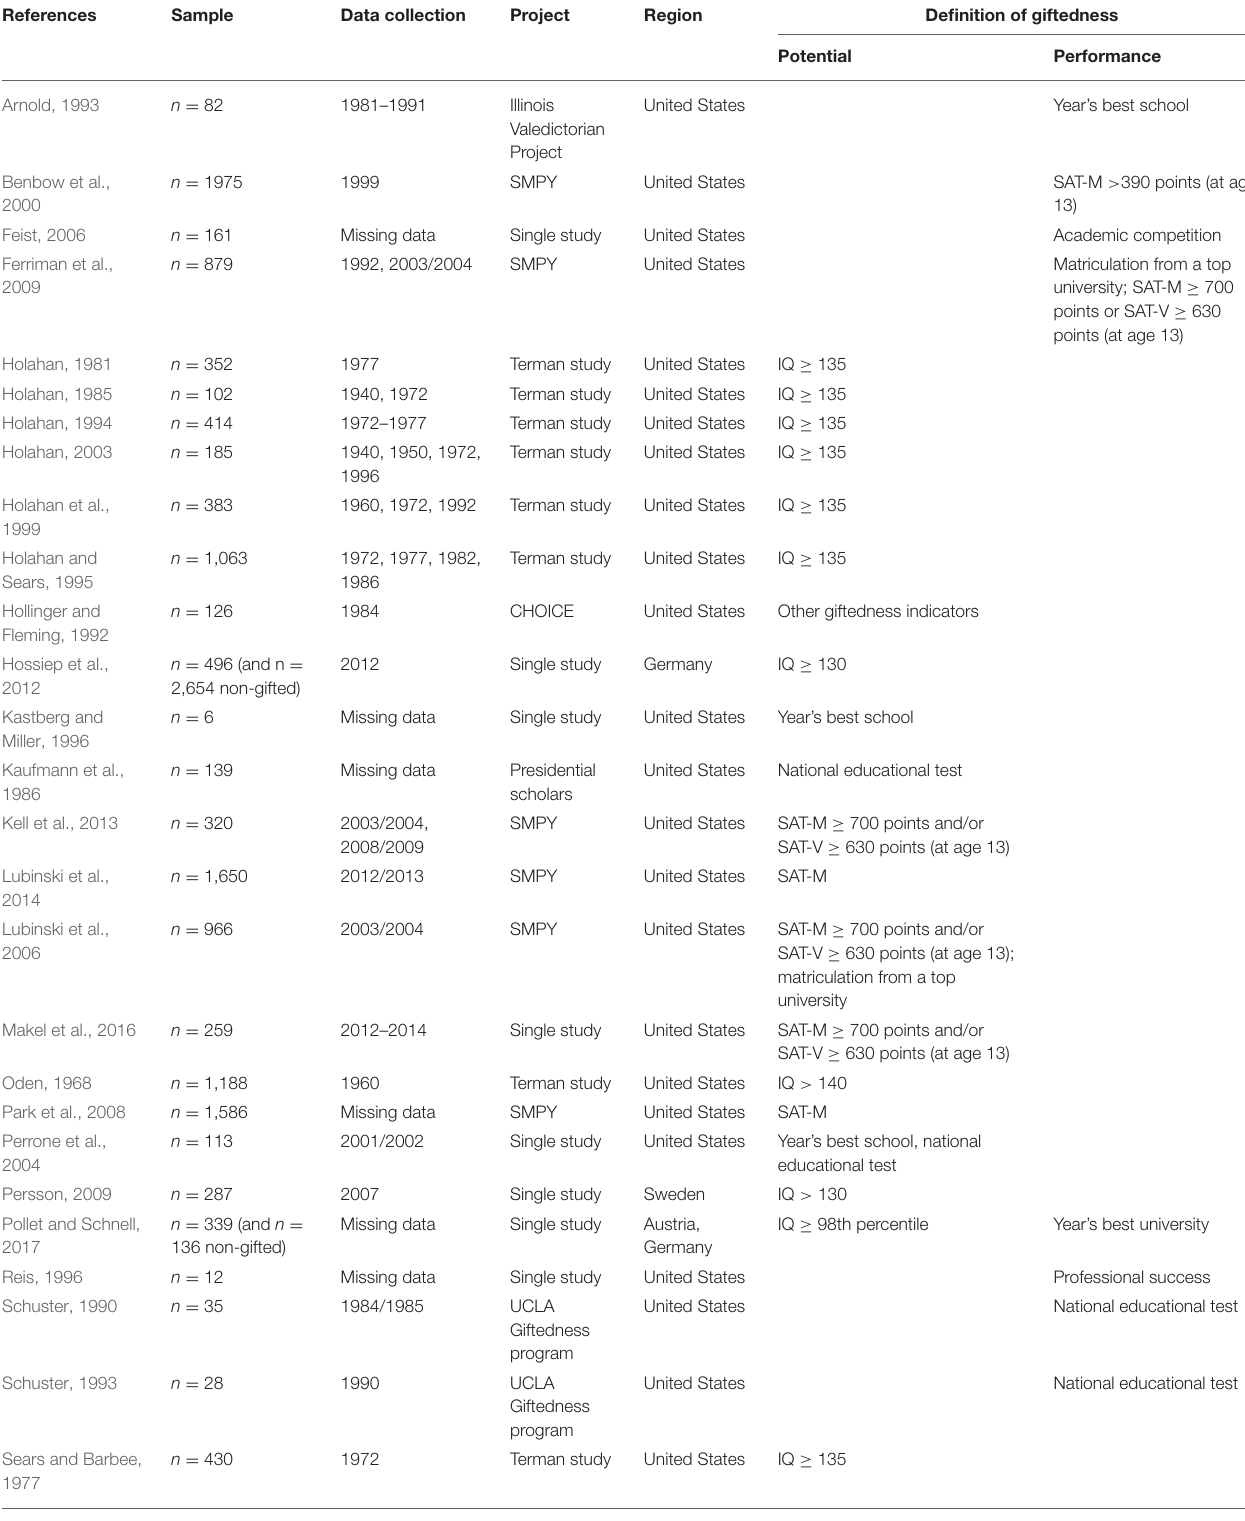
TABLE 2 | Included studies with information on the region, data collection, sample, and definition of giftedness